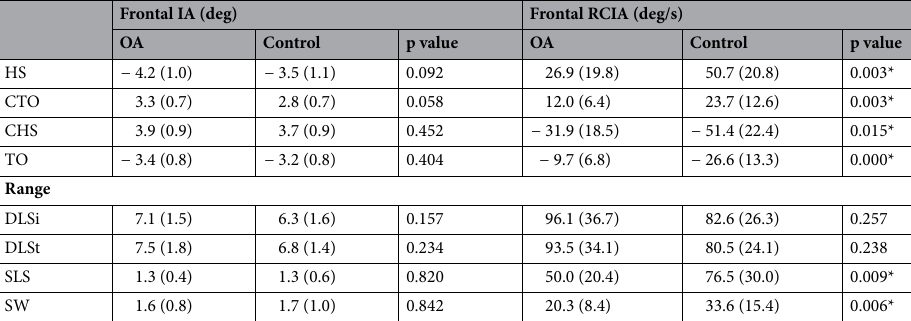
Table 4. Means (standard deviations) of the frontal inclination angles (IA) and the rate of change of IA (RCIA) at heel-strike (HS), contralateral toe-off (CTO), contralateral heel-strike (CHS) and toe-off (TO), as well as average values and ranges of IAs during single-limb support (SLS), swing (SW), initial double-limb support (DLSi) and terminal double-limb support (DLSt). p values for comparisons between knee OA and Control using independent t test are also shown. All significance levels were set at α = 0.05. *OA significantly different from